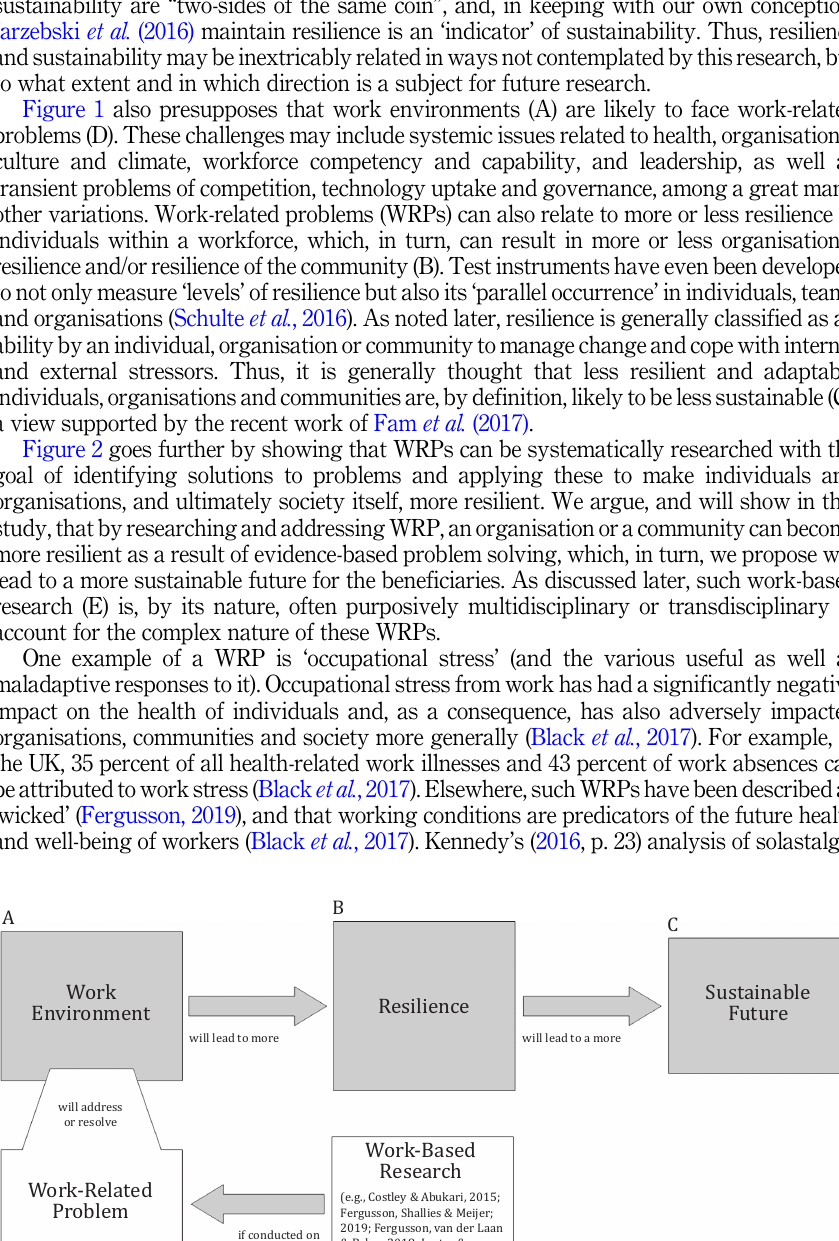
Figure 2. Proto-theoretical